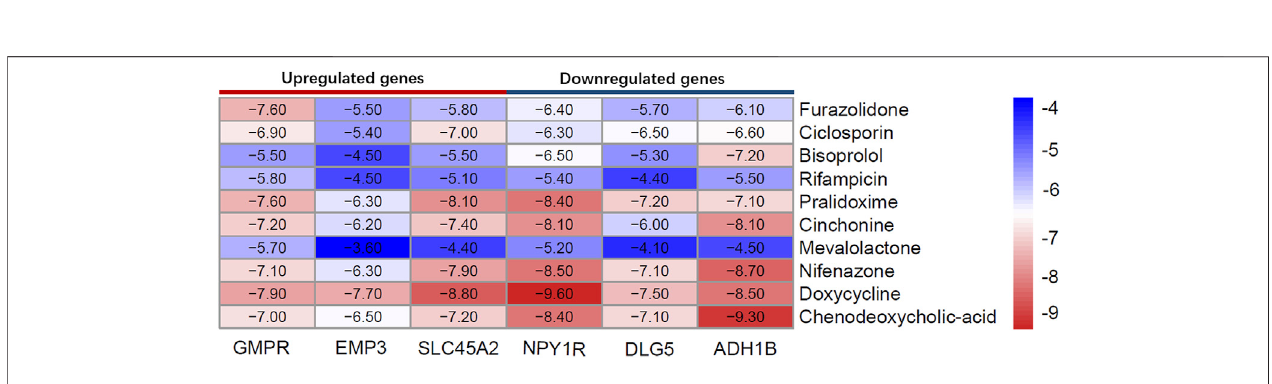
FIGURE 10 | Chemical structure depiction of the top ten most signi fi cant drugs. (A) Furazolidone (B) Ciclosporin (C) Bisoprolol (D) Rifampicin (E) Pralidoxime (F) Cinchonine (G) Mevalolactone (H) Nifenazone (I) doxycycline (J) chenodeoxycholic acid.